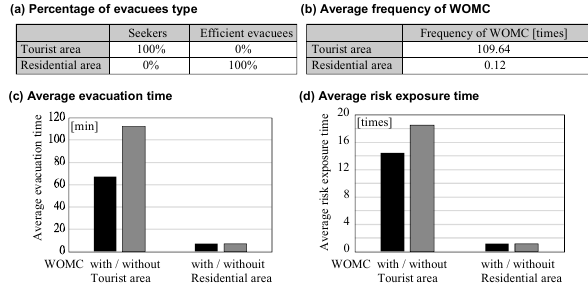
Figure 9. Influence of WOMC in each virtual city type